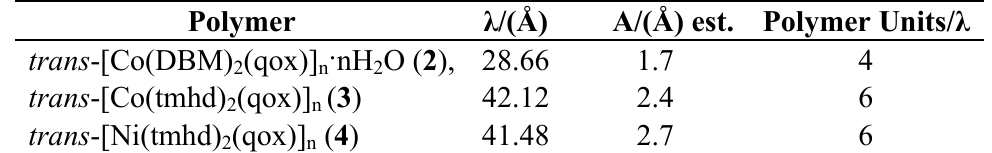
Table 3. Wavelengths, amplitudes, and repeating units per wavelength for the polymer